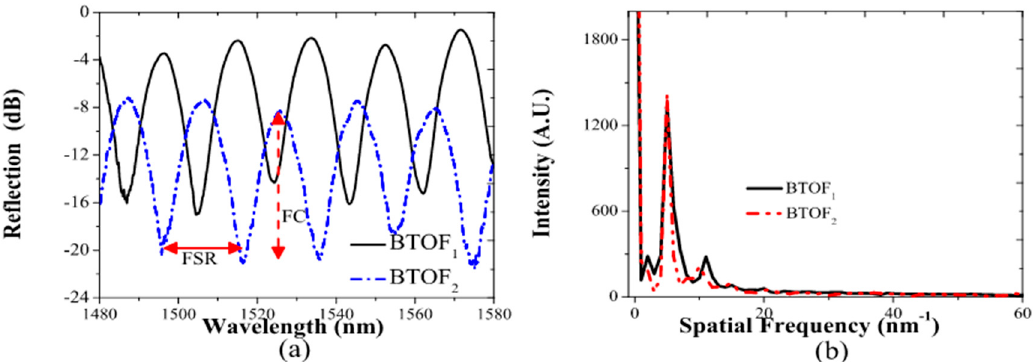
Figure 2. ( a ) Reflection spectrum of the fabricated BTOFs (BTOF1 and BTOF2); ( b ) spatial frequency spectrums of the BTOFs.